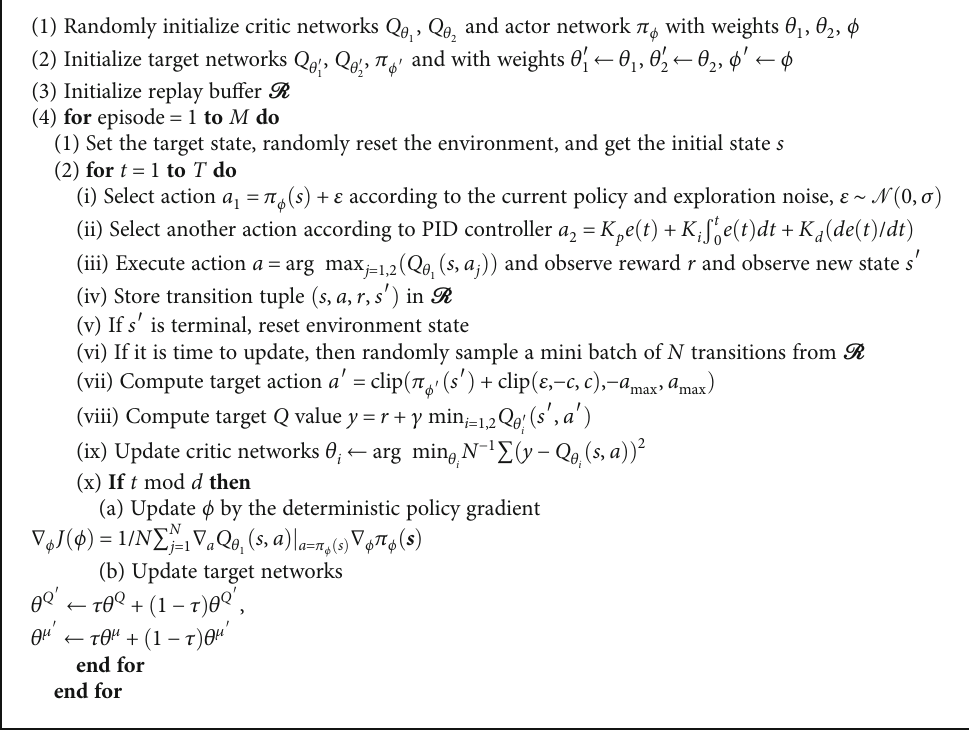
Algorithm 1: PID-Guide TD3 Algorithm. Table 1: Actor and critic network architecture.